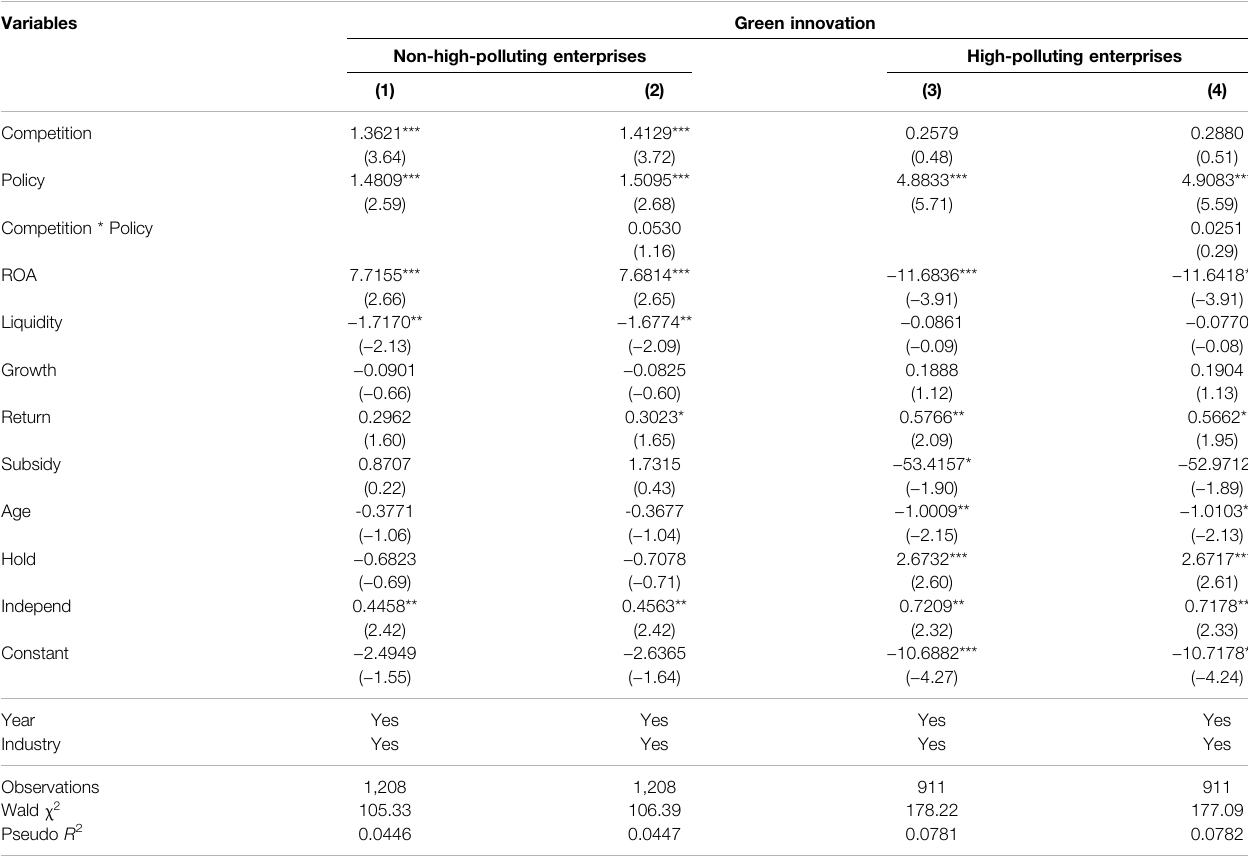
TABLE 7 | Results of non-high-polluting and high-polluting